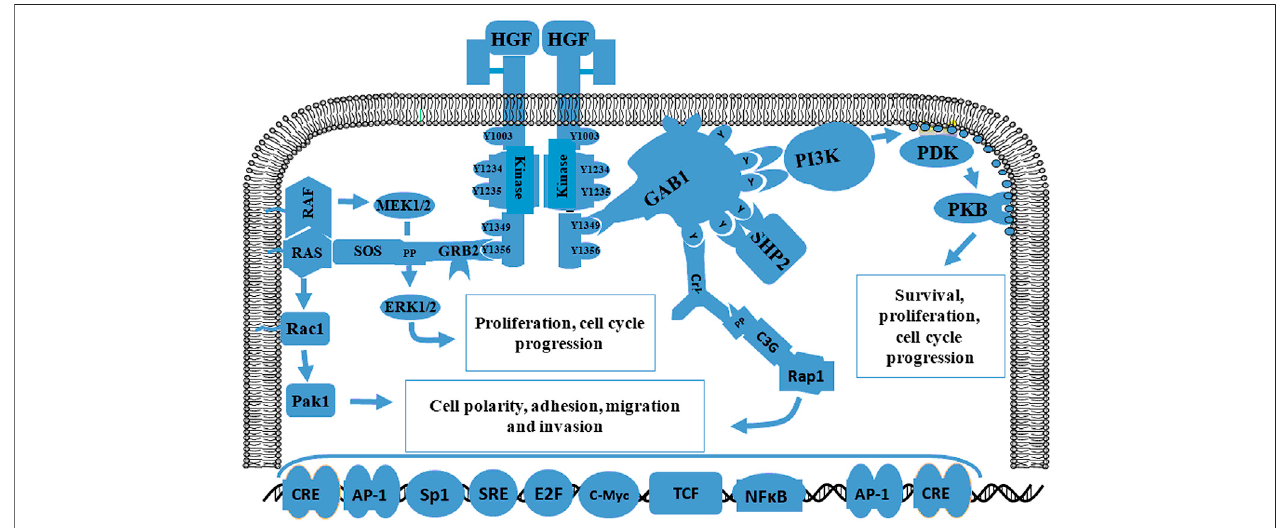
FIGURE 3 | Schematic diagram of the MET signaling pathway related to proliferation, migration, and invasion. The initiation of MET signaling activates several signalsincludingGab1,Grb2,Ras,SOSandShp2andthesubsequentphosphorylationofdownstreammoleculessuchasSTAT3andRas/MAPK/ERK.Theinteraction between MET and HGF plays a crucial role in proliferation, survival, migration, invasion, treatment resistance, and GBM recurrence.